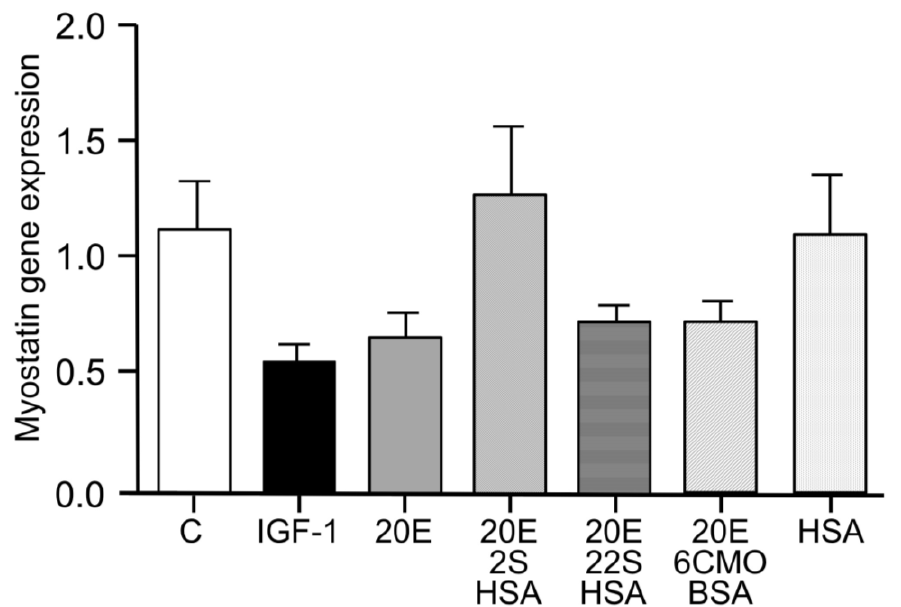
Figure 5. 20E reduction of myostatin gene expression in C2C12 cells (differentiated for 6 days into myotubules) is mediated by binding to receptor sites on the external surface of the cells. The histogram compares the activities of IGF-1 (100 nM) and 20E (10 µ M) with those of conjugates of 20E covalently bound to protein (HSA or BSA) through different C-atoms (C-2 and C-22-hemisuccinates or C-6 [6-carboxymethoxime]), all at nominal 10 µ M hapten concentration. BSA bovine serum albumin; HSA: human serum albumin; error bars = standard error of the mean [103,114].